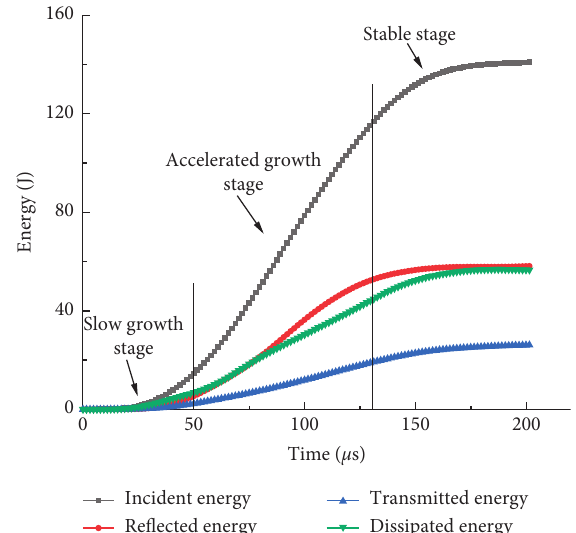
Figure 6: Energy evolution curve of typical layered composite rock